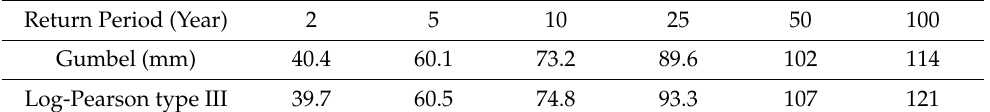
Table 4. The maximum 24 h rainfall depths for different return period of J204 station.